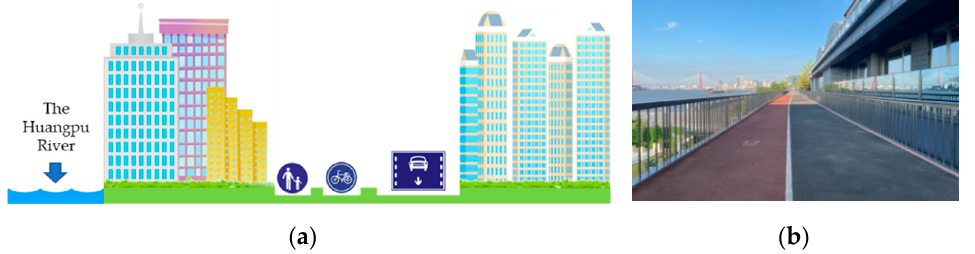
Figure 3. The built form of greenway along the Huangpu River in Shanghai (built greenway), seen from the perspective of ( a ) greenway designer and ( b ) greenway user, often have a wide sense of space and are combined with the construction of other municipal roads. On one hand, residents who exercise along these greenways have improved vision. On the other hand, built greenways are often affected by vehicle exhaust fumes, which reduce the air quality, and also the high-speed vehicles close to greenways reduce the safety coefficient for residents.